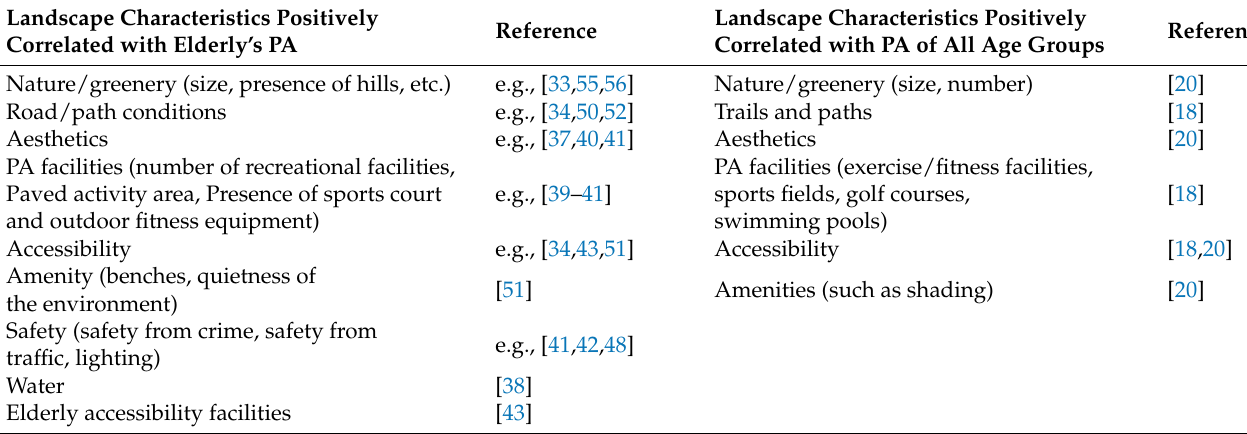
Table 5. The comparison of landscape characteristics positively correlated with the elderly’s PA and all age